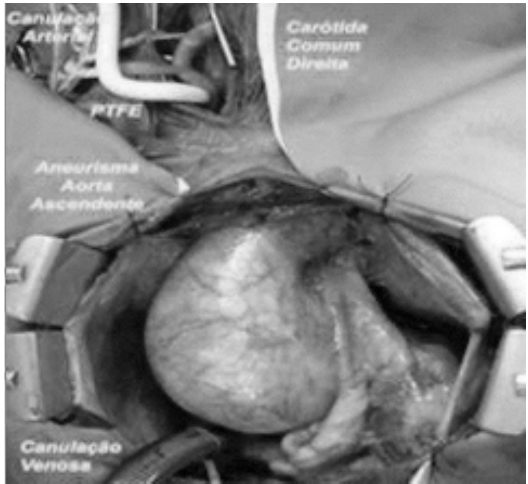
Fig. 2 - Aspecto cirúrgico da perfusão pela artéria carótida direita através de tubo de PTFE conectado à linha arterial da